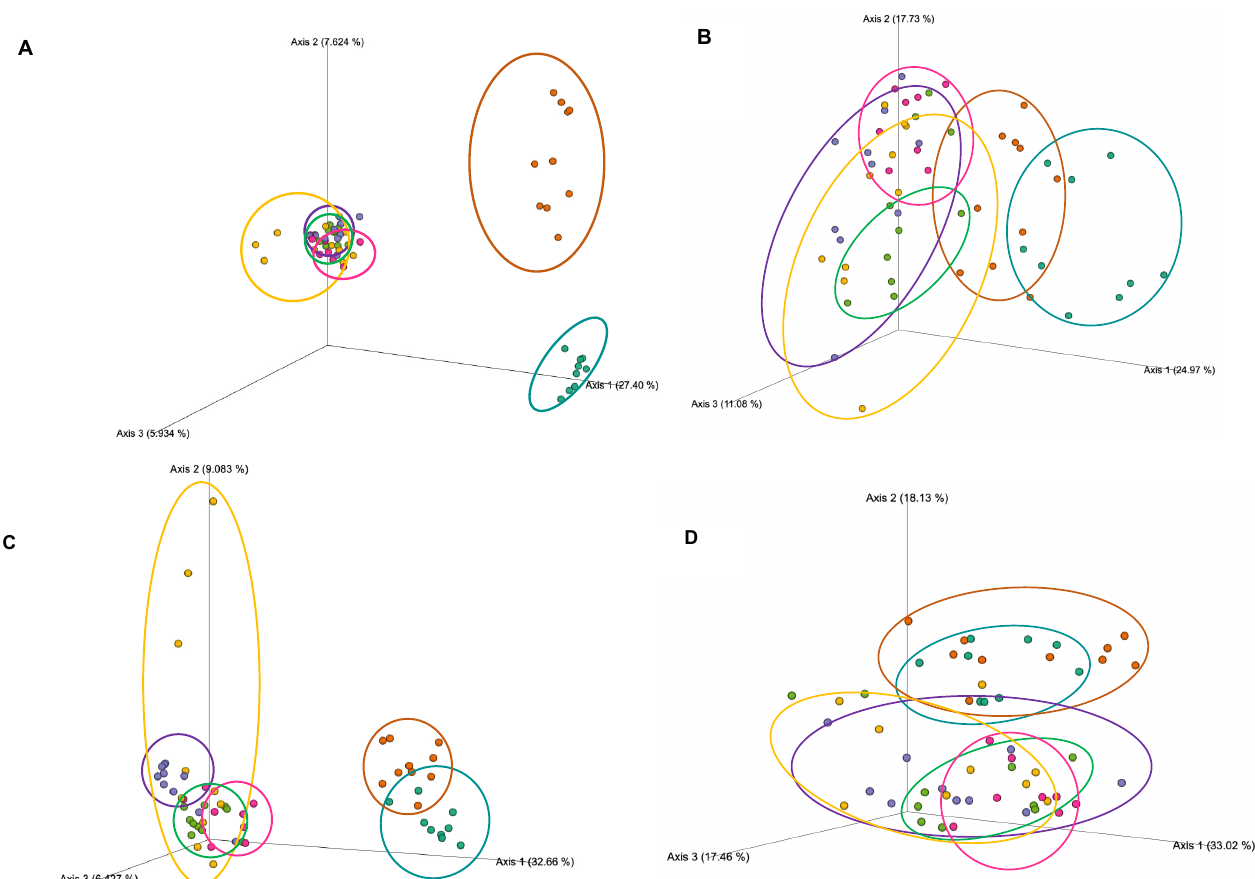
Figure 5. Microbial beta-diversity (between group diversity) PCoA plots representing gut microbiota diversity after 24 weeks following six different dietary and exercise interventions: ( A ) Jaccard distance matrix, ( B ) Bray–Curtis distance matrix values, ( C ) unweighted UniFrac distance matrix, and ( D ) weighted UniFrac distance matrix values. Treatment groups are as follows: unpurified diet (chow), turquoise; high-fat, high-sugar diet + chow (HFD + chow), orange; HFD, purple; HFD + exercise (HFD + Exe), green; HFD + genistein (HFD + Gen), pink; and HFD + Exe + Gen, yellow. Benjamini– Hochberg corrections for multiple comparisons were performed for each